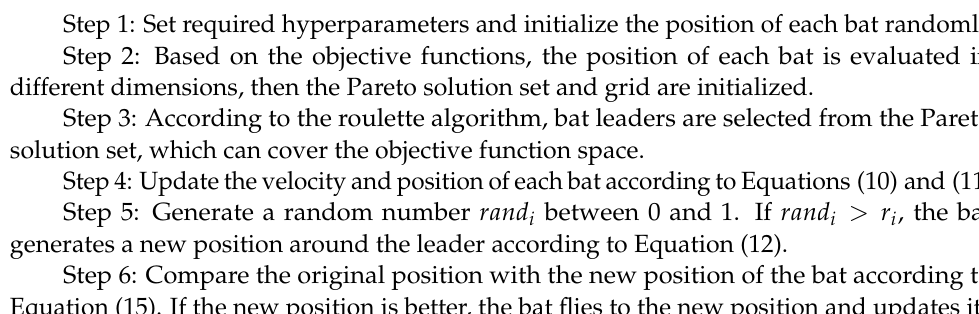
Figure 4. Optimization flow chart of the multi-objective bat algorithm with grid.